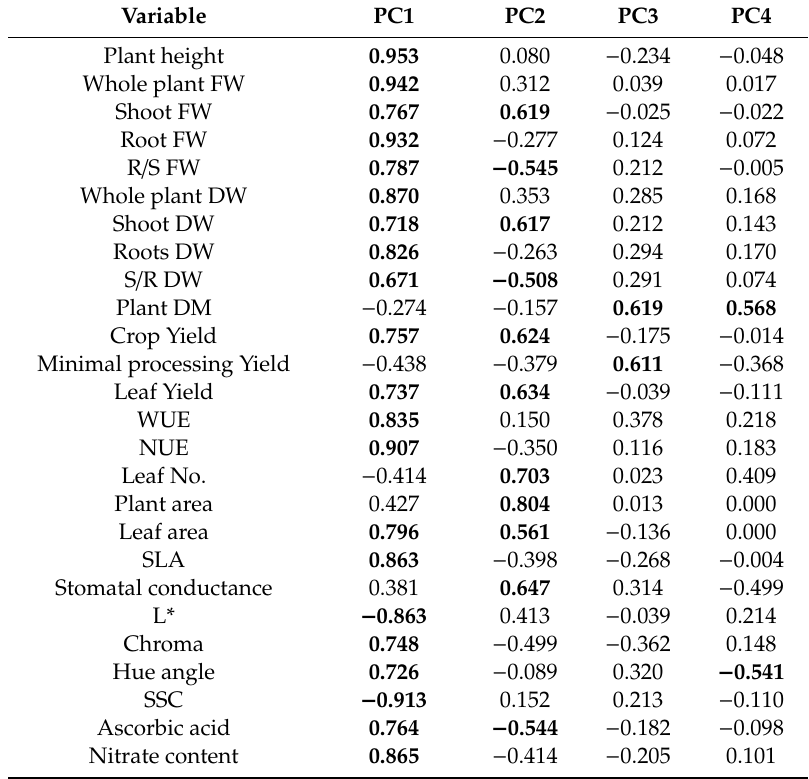
Table 5. Correlation of variables to the factors of the principal components analysis (PCA) based on factor